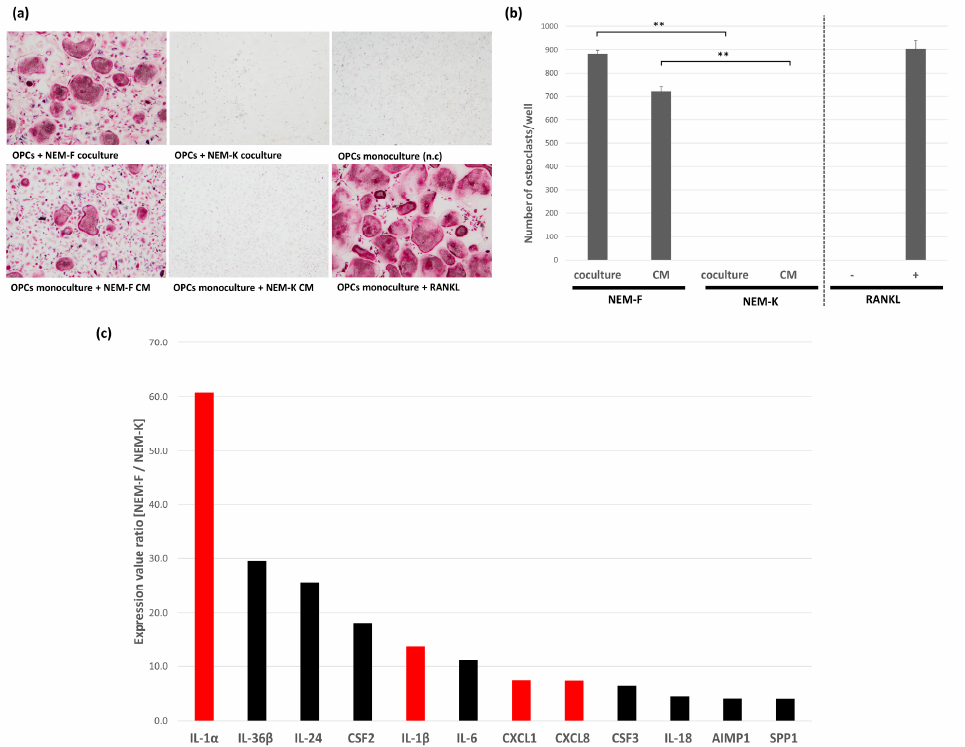
Figure 1. Osteoclastogenic properties of two subclones derived from the OSCC cell line, NEM. ( a ) Representative views of TRAP staining 5 days after the coculture of NEM-F or NEM-K cells with OPCs, and 5 days after the culture with culture supernatant of NEM-F or NEM-K cells. After 5 days of culturing OPCs in the growth medium supplemented with or without RANKL, the cells also functioned as positive and negative controls. ( b ) The number of osteoclasts induced by NEM-F relative to that induced by NEM-K, and the number of osteoclasts induced in cultures of OPCs supplemented with RANKL relative to that without supplementation of RANKL in the growth medium. ** p < 0.01 (one-way ANOVA with the Tukey–Kramer method). ( c ) Gene expression value ratio in NEM-F relative to that in NEM-K, analyzed with the gene expression microarray, sorted by the ratio as “>4-fold” and the GO Molecular Function Term as “cytokine activity”. Red bars represent selected inflammatory cytokines that have been reported to have an association with osteoclastogenesis. Preferential expression of the selected inflammatory cytokines was also detected in a gene expression microarray analysis used in our previous study (NCBI Gene Expression Omnibus,